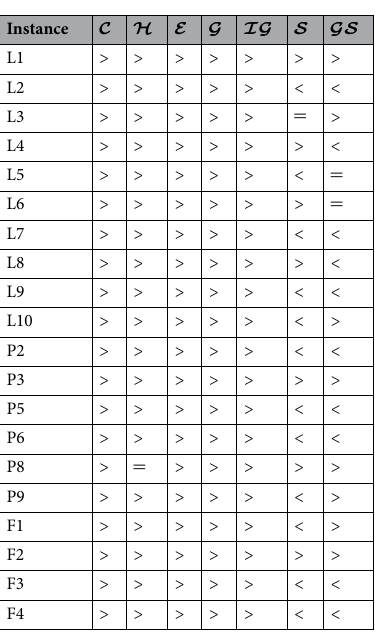
Table 9. Wilcoxon–Mann–Whitney statistical test for 3PHEA against